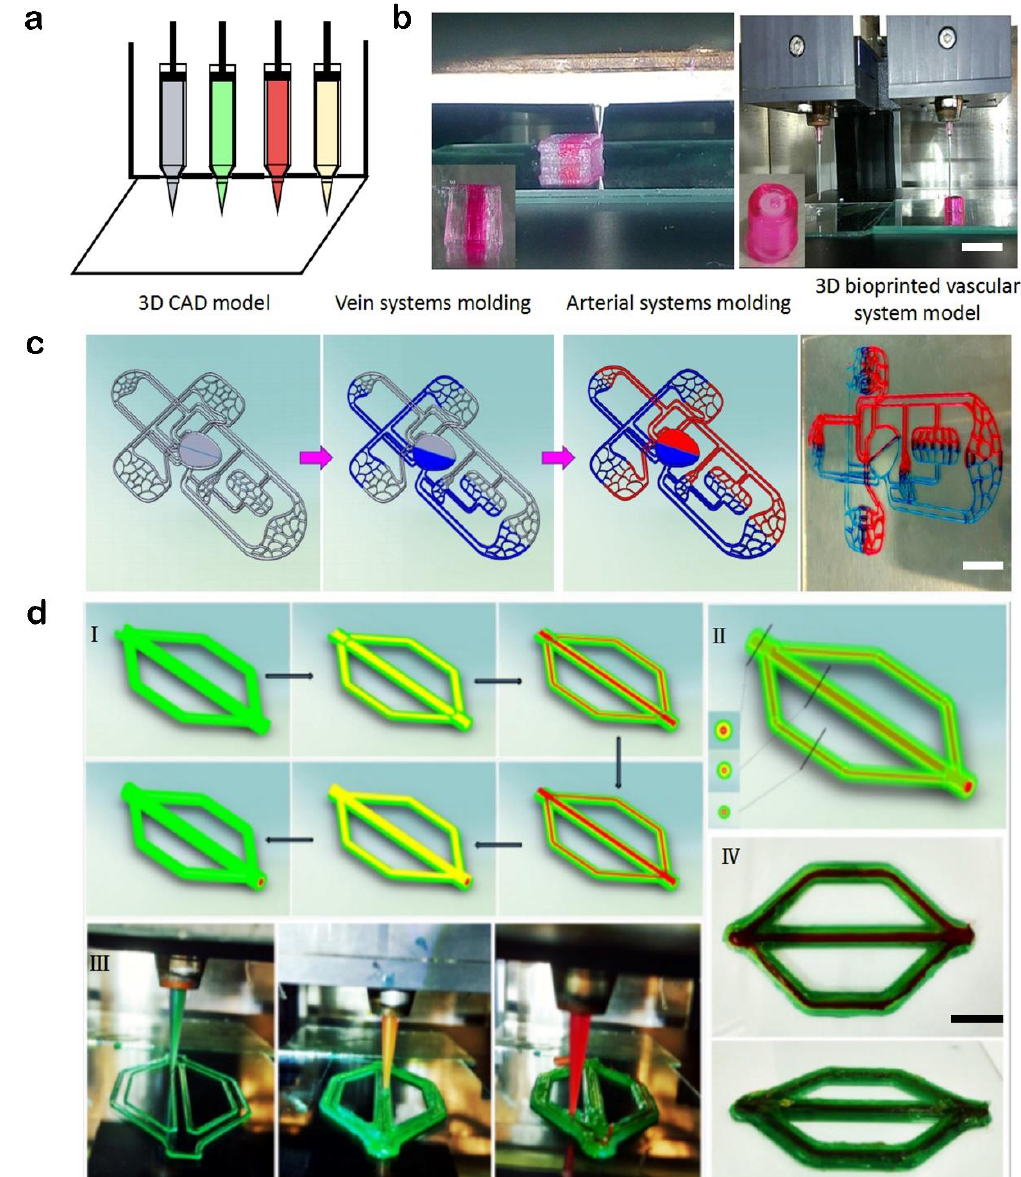
Figure 4. ( a ) Schematic diagram showing four independent nozzles of the 3D bioprinter. ( b ) Fabrication of tissue structures using a multiple nozzle system (Scale bar: 2 cm). ( c ) Model formation schematics of the vascular system containing arteries and veins and the actual vascular system model (Scale bar: 2 cm). ( d ) A specially designed vascular model with three layers of structure (Scale bar: 1 cm).